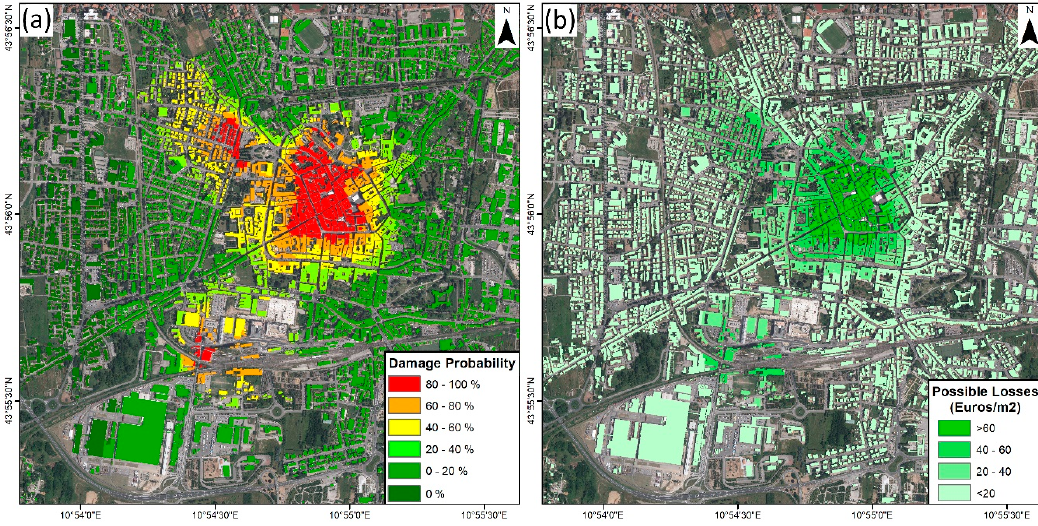
Figure 9. ( a ) Damage probability of each cadastral plot. ( b ) Vulnerable assets.